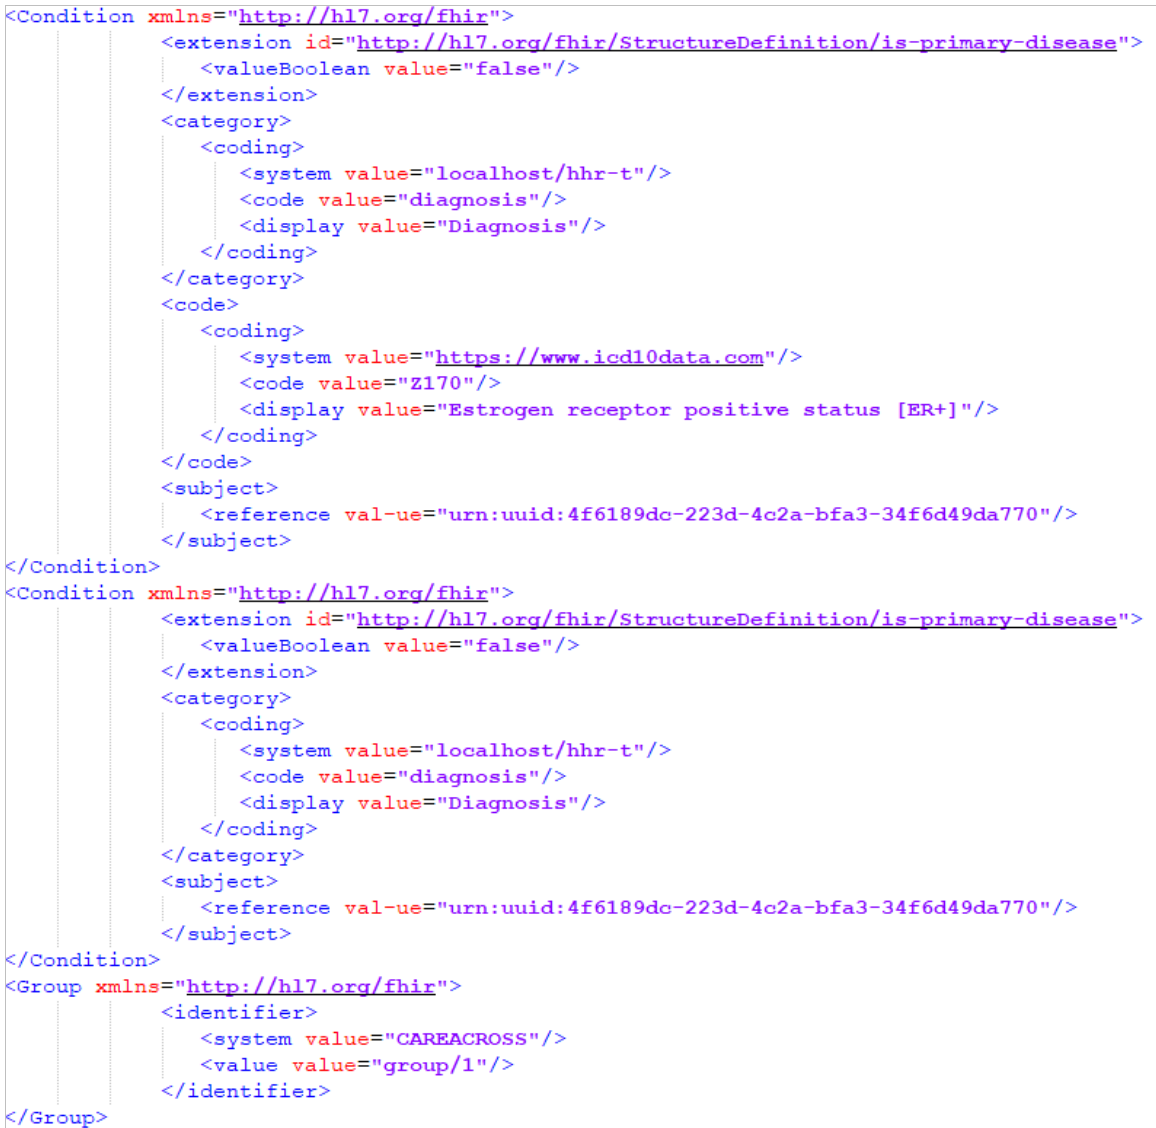
Figure 7. Final output of CareAcross data from the Data Conversion